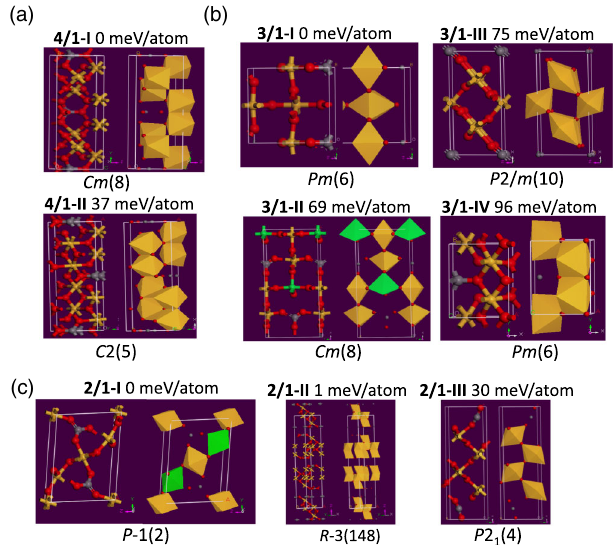
FIG. 1 (color online). Low-enthalpy structures of the (a) ð SiO 2 Þ 4 ð CO 2 Þ 1 , (b) ð SiO 2 Þ 3 ð CO 2 Þ 1 , and (c) ð SiO 2 Þ 2 ð CO 2 Þ 1 compounds, respectively. Atoms in gold, grey, and red colors are Si, C, and O,